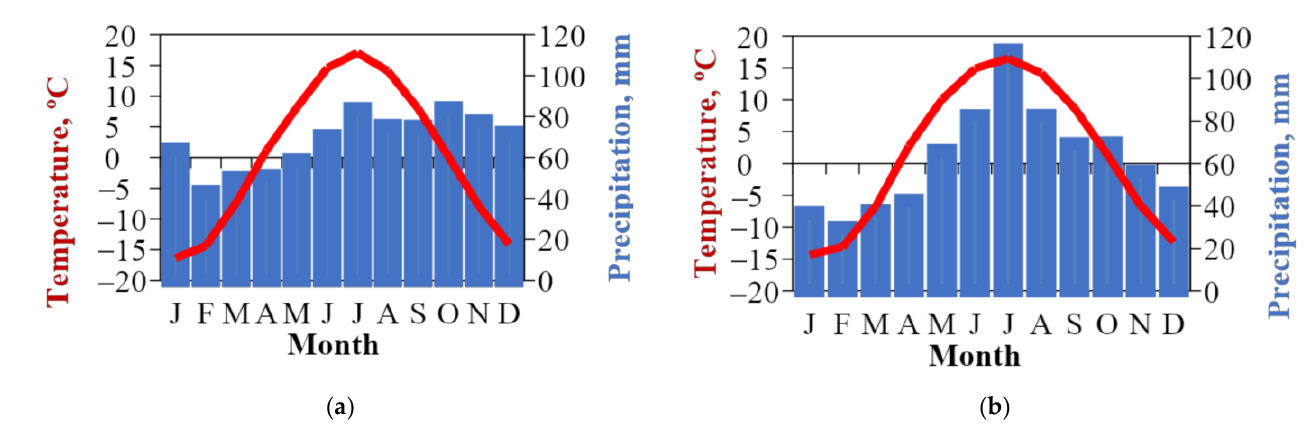
Figure 1. Study area ( a ) in the Russian Urals and views ( b , c ) of some studied J. sibirica populations. Site codes: 1 —Molebnyi Kamen’; 2— Zyryanovka; 3 — Kvarkush; 4 — Taganay; 5 — Nurgush; 6 — Zigalga; 7 — Iremel. Images correspond to Zyryanovka (( b ), number 2 on the map) and Iremel (( c ), number 7 on the map) sites, respectively. The blue circles indicate the weather stations: Troicko – Pecherskoe (TP), Cherdyn (Ch), and Taganay – Gora (TG). Table 1. Geographical position and conditions of the study plots. Snow depth values were measured in late March (means ± SD).